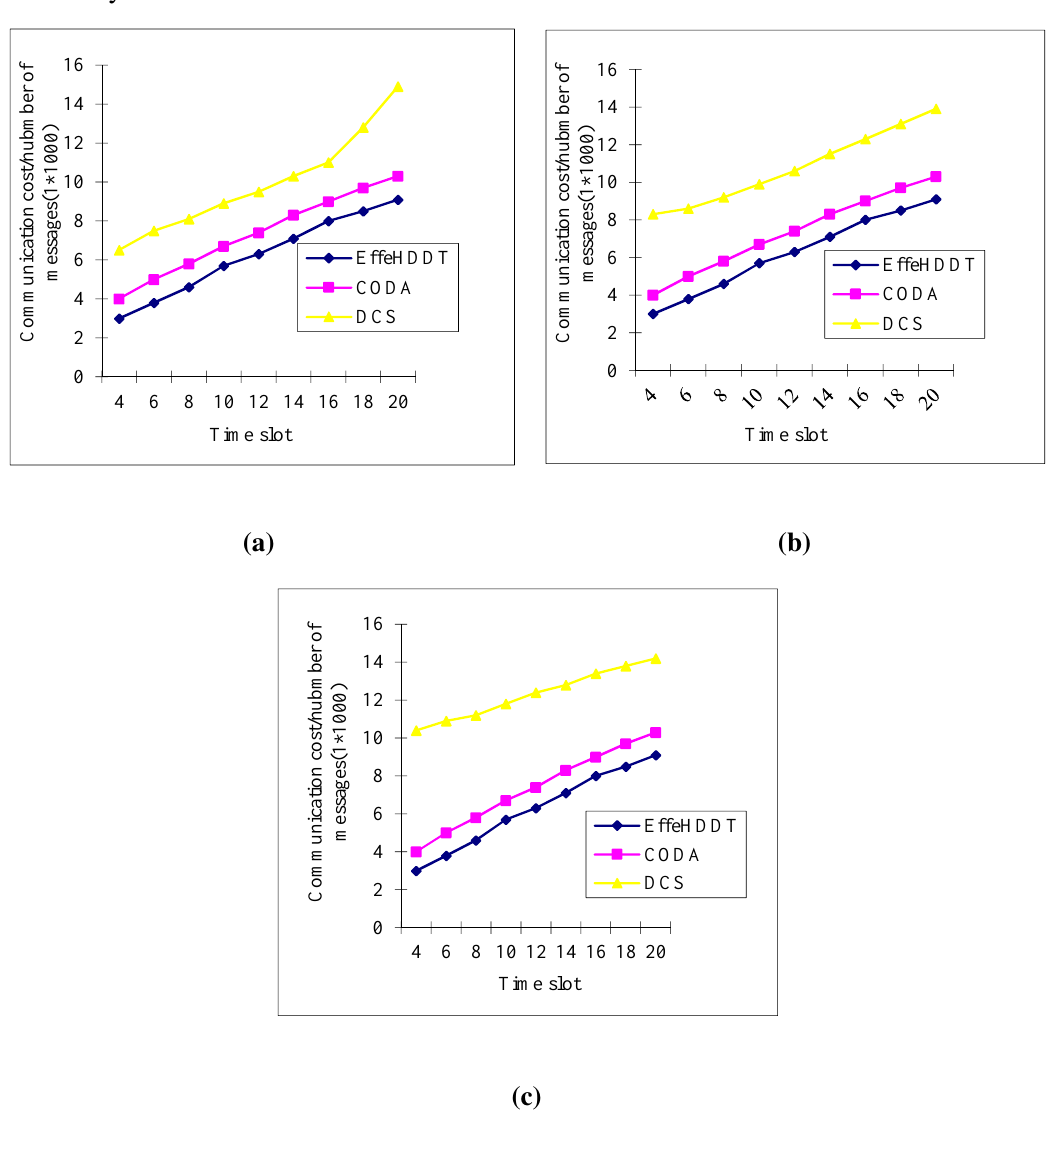
Figure 11. Communication costs over time (EffeHDDT with 50 domains and CODA with 50 clusters). ( a ) DCS with 50 dynamic clusters; ( b ) DCS with 100 dynamic clusters; ( c ) DCS with 150 dynamic